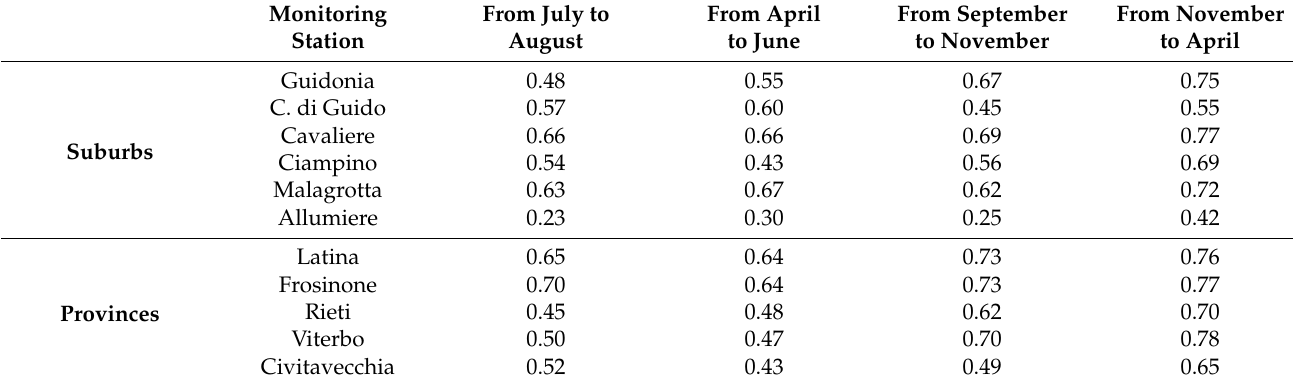
Table 7. Cross-correlation values between Roma Green Band and suburbs or province stations of [NO 2 ] in 2015. Monitoring